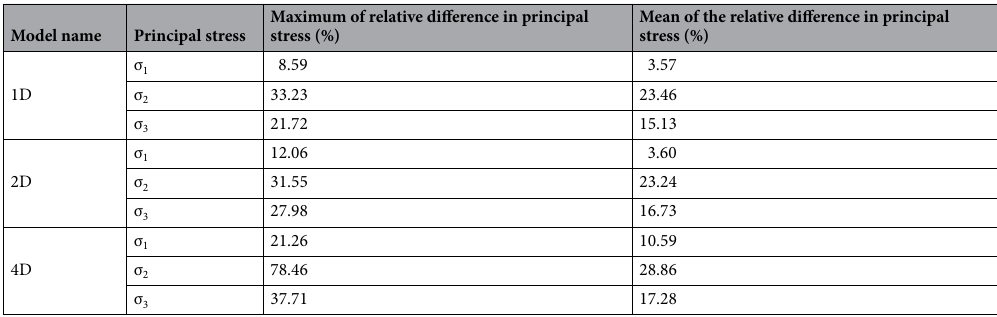
Table 3. Summary of the relative difference in principal